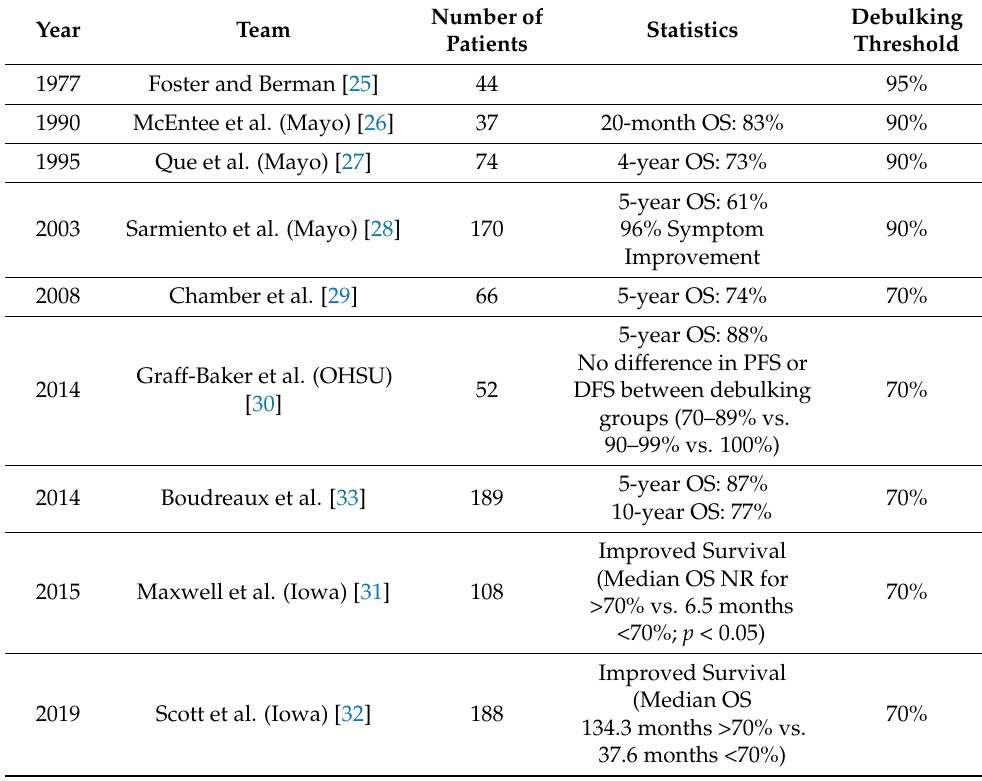
Table 1. Studies defining the NETLM debulking